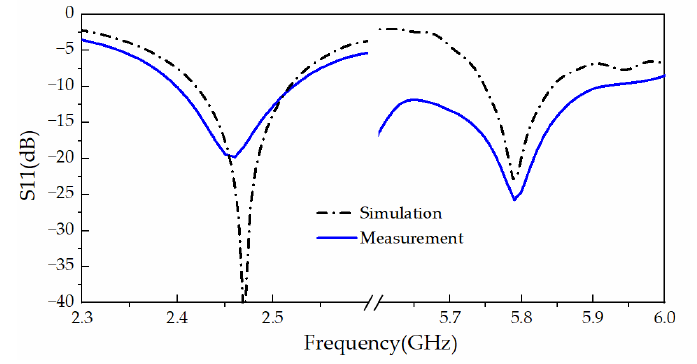
Figure 7. Simulated and measured S11 of the proposed DRA array.